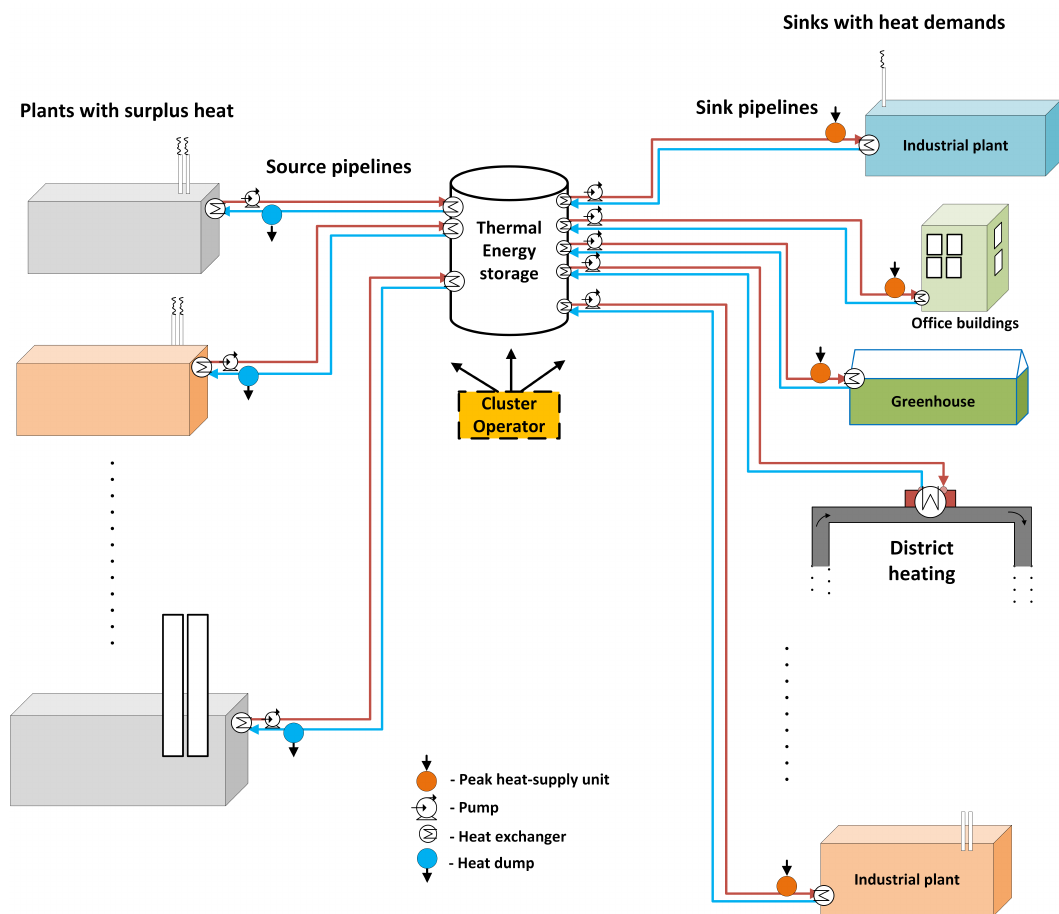
Figure 1. Conceptual illustration of surplus-heat exchange and utilization in an industry cluster. The red lines indicate hot supply water and blue lines cold return